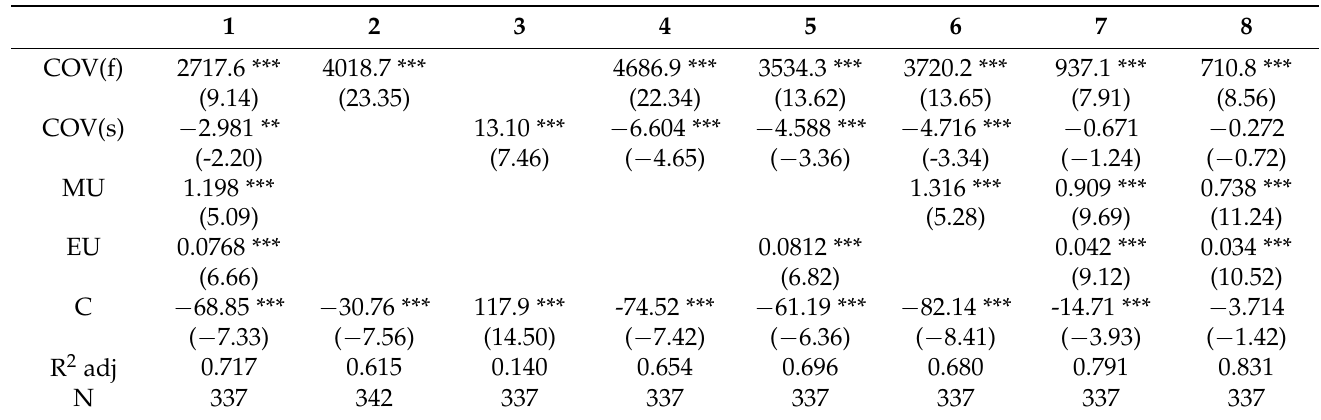
Table 7. COVID-19 death announcements, Chinese volatility, and oil price volatility, Asian data.